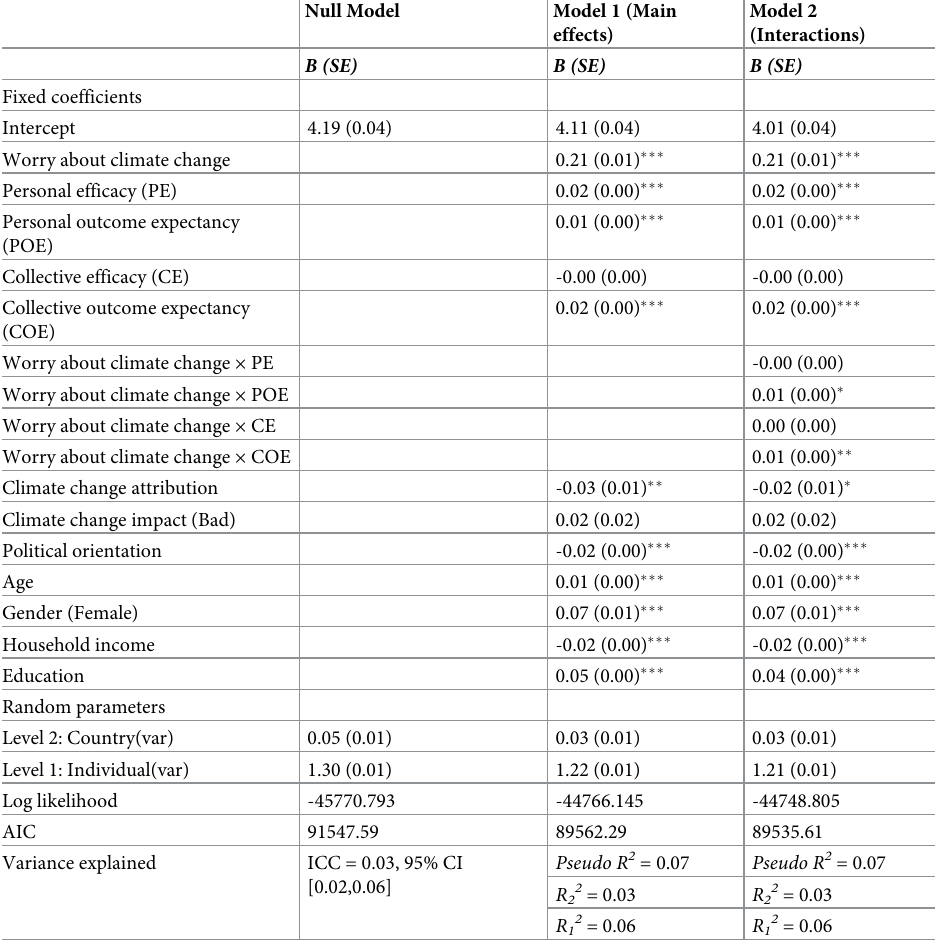
Table 3. Model results–Energy curtailment